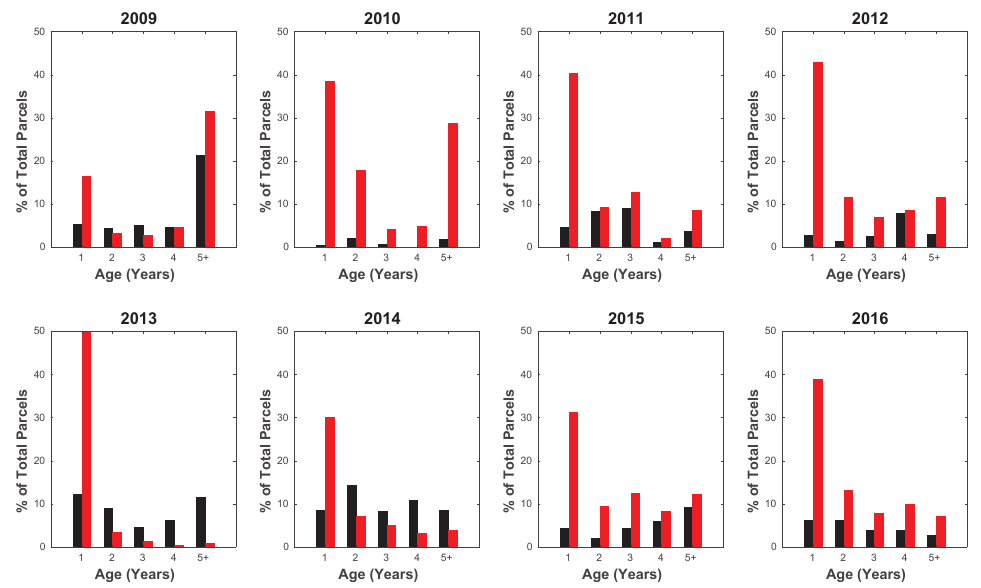
Figure 4. Percent of population in age categories 1–5+ years for surviving ( black ) and melted ( red ) ice parcels in the Beaufort Sea during 2009–2016.